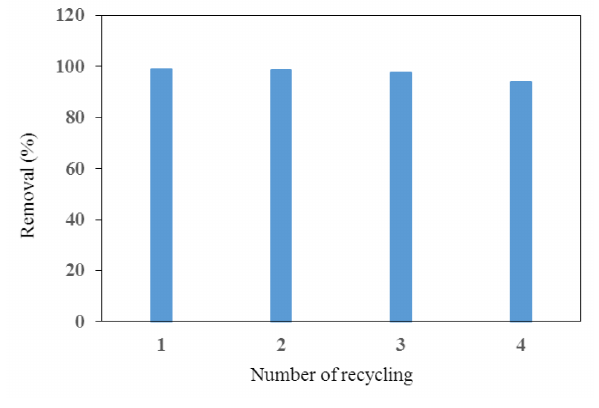
Figure 12: Plot of the reusability test adsorption of MB removal onto hierarchical